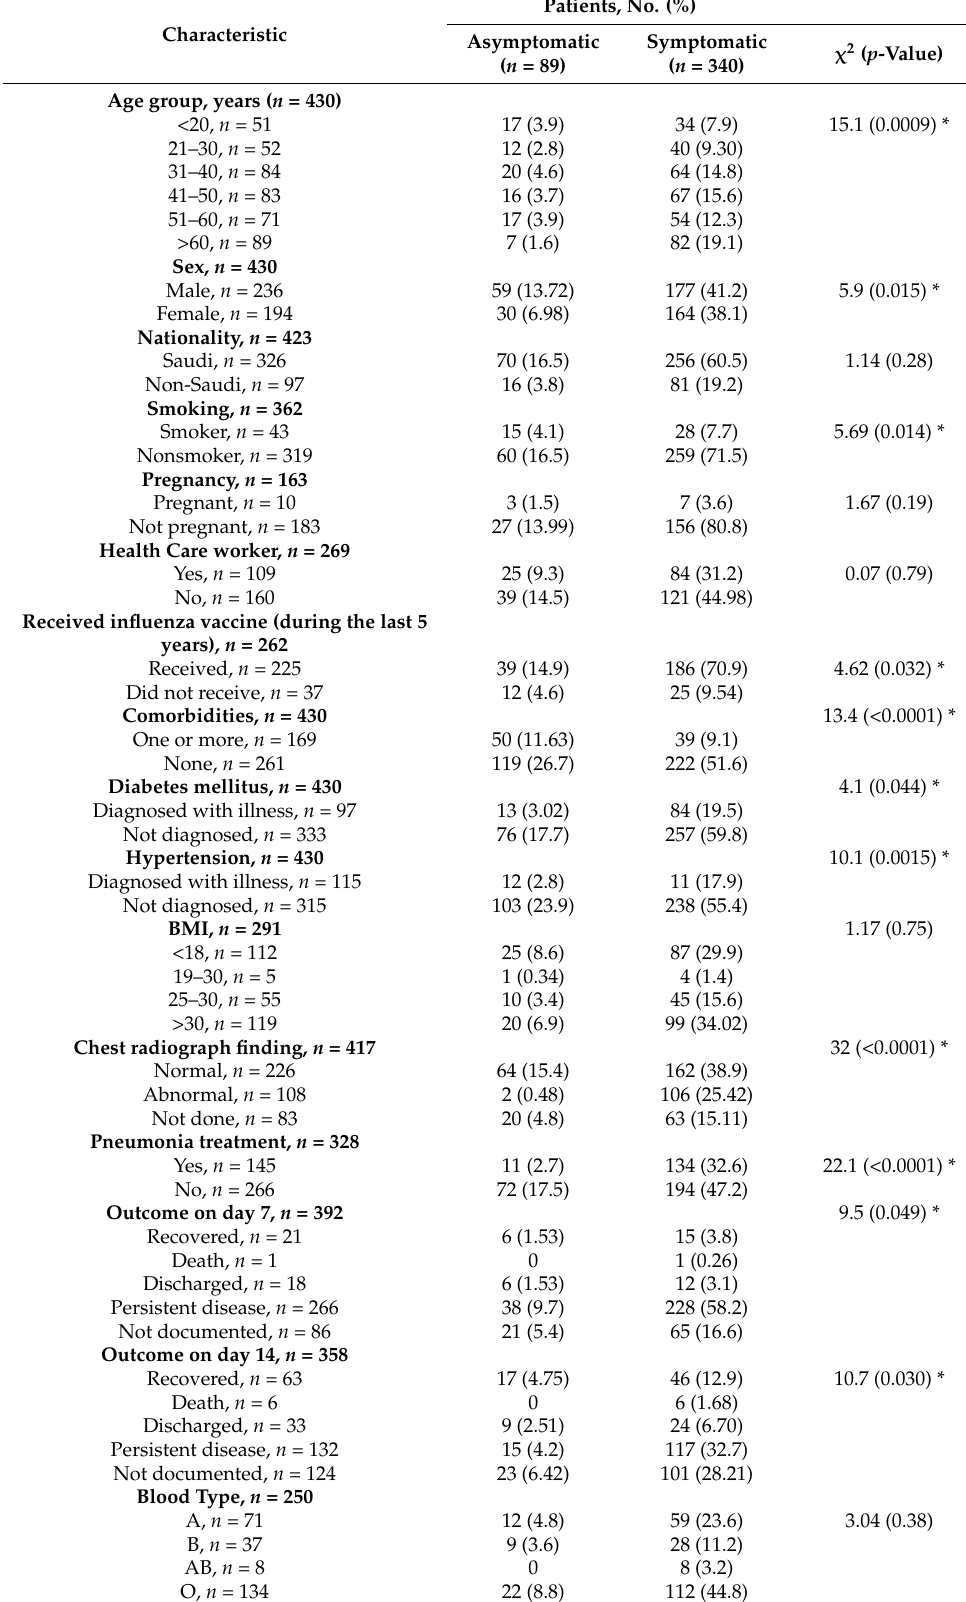
Table 3. Categorical demographic and clinical characteristics assessed by symptomatic vs. asymp- tomatic